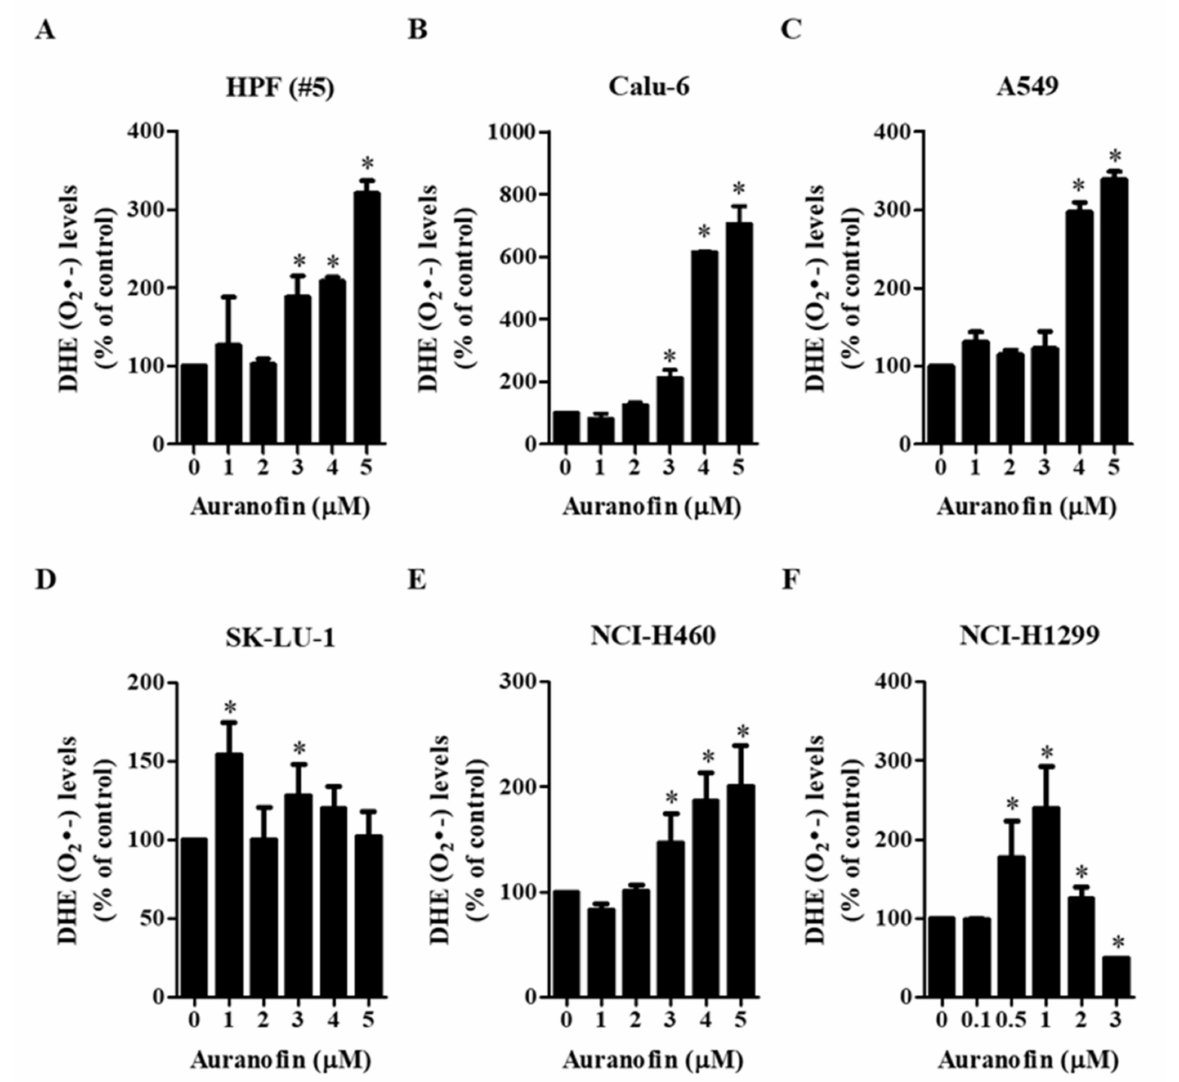
Figure 3. Effects of auranofin on intracellular DHE (O 2 •− ) levels in lung cancer cells. Exponentially growing cells were incubated in the presence of the indicated concentrations of auranofin for 24 h. DHE (O 2 •− ) levels in cells were measured using a FACStar flow cytometer. Graphs illustrate DHE (O 2 •− ) levels (%) in normal HPF cells ( A ) and cells from the lung cancer cell lines Calu-6 ( B ), A549 ( C ), SK-LU-1 ( D ), NCI-H460 ( E ), and NCI-H1299 ( F ), compared with each group of control cells. * p < 0.05 compared with the auranofin-untreated control